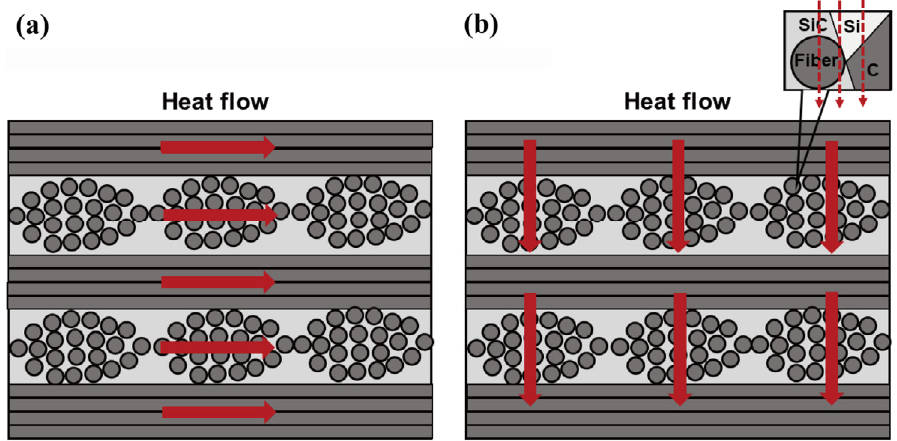
Fig. 9 Schematic diagram of heat transfer in different directions of the composites.